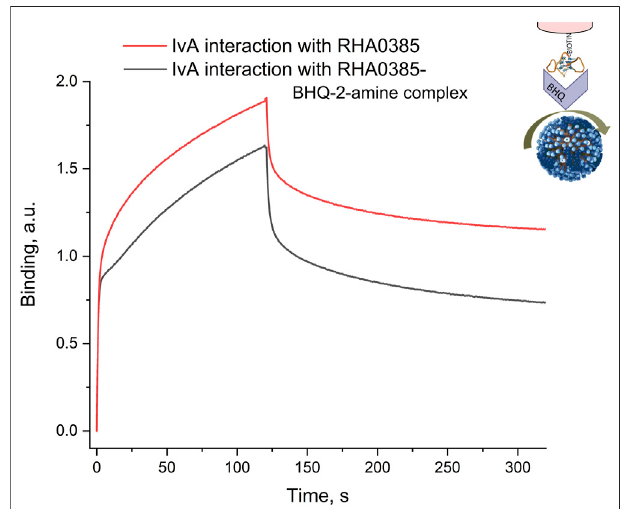
FIGURE 7 | Interaction between the aptamer and its complex with the BHQ-2 amine and the in fl uenza A virus assessed by biolayer interferometry. The aptamer was incubated in the buffer or in a 1 µM solution of the BHQ-2 amine and then interacts with 4 · 10 3 HAU/ml solution of IvA.